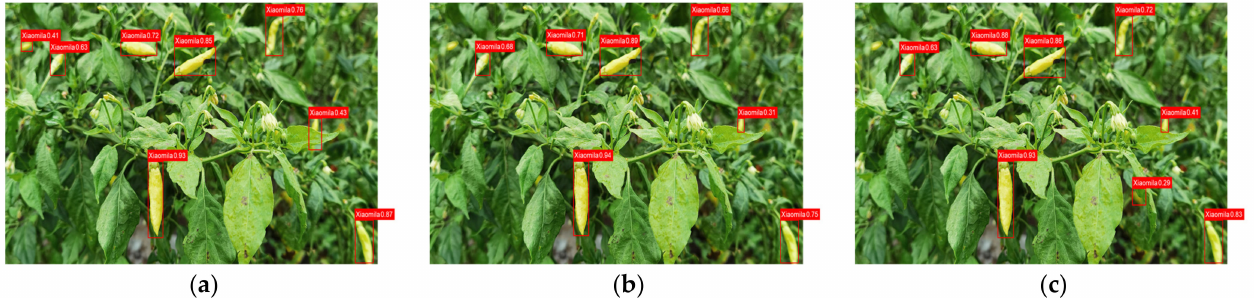
Figure 14. Comparison of the detection results of different models in small target detection. ( a ) YOLOv5s-CFL detected all labeled targets; ( b ) YOLOv5s missed one fruit covered by leaves; ( c ) YOLOv3-tiny missed fewer fruits covered by